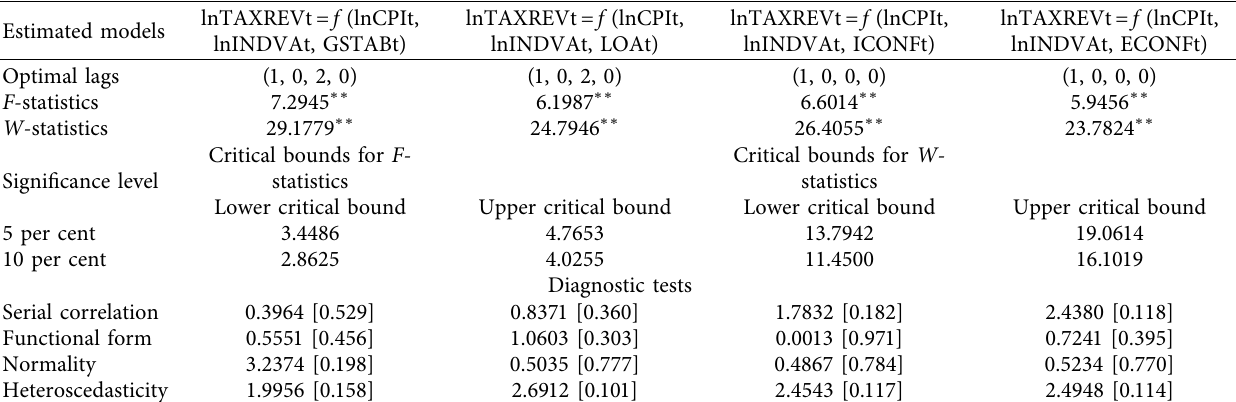
Table 5: ARDL bounds testing